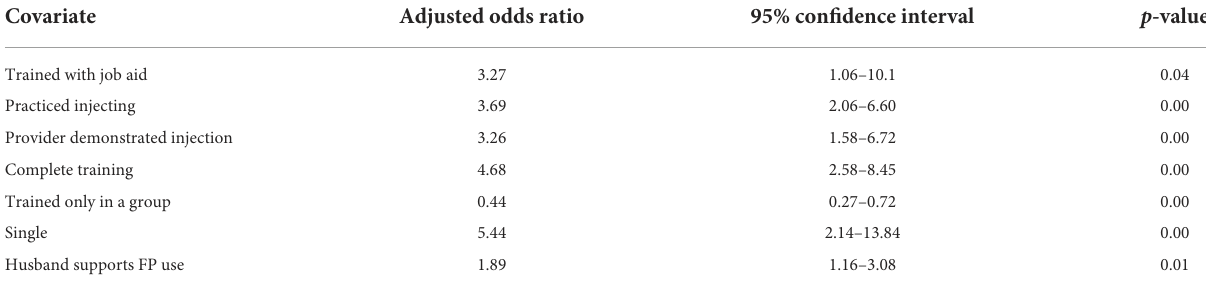
TABLE 5 Mixed effects multivariate logistic regression of whether self-injection